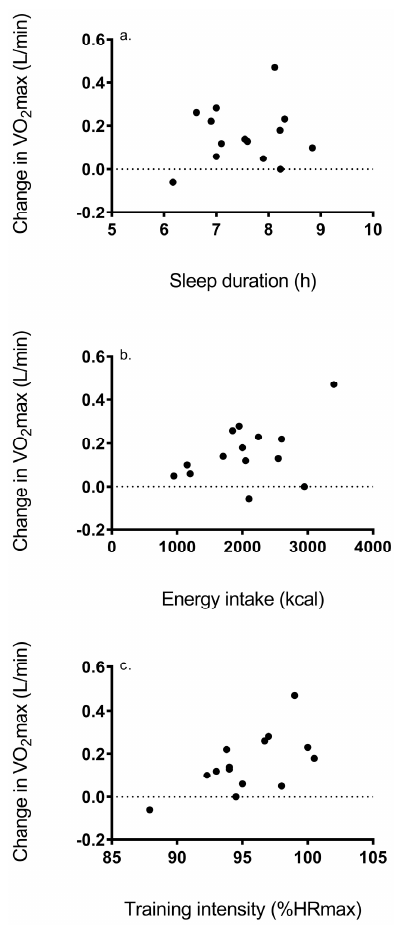
Figure 2. Association between change in VO 2 max and ( a ) sleep duration, ( b ) dietary intake, and ( c ) training intensity expressed as % HRmax.